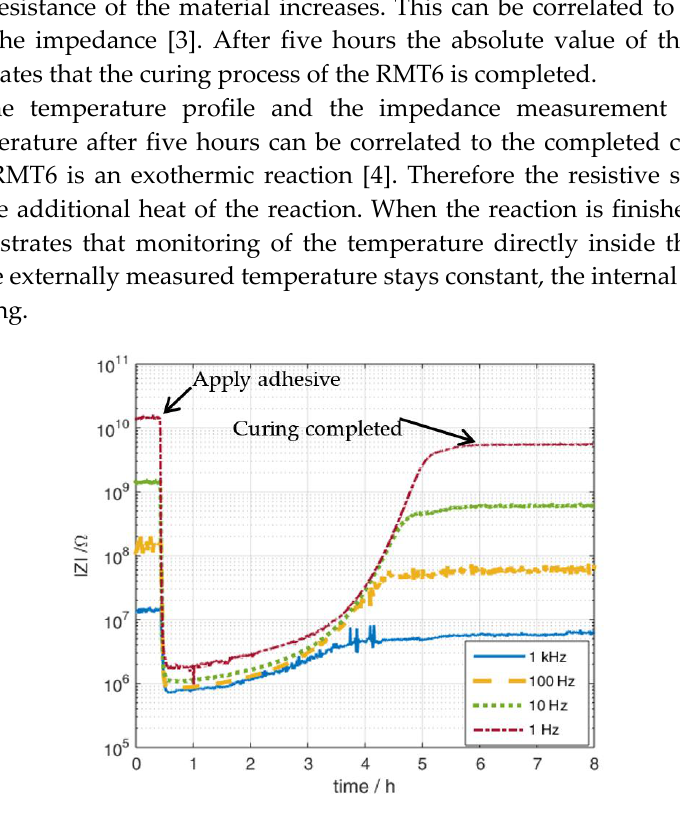
Figure 4. Absolute impedance over time for selected frequencies during curing of RTM6 ( Hexel ) resin. In a first step the RTM6 get less viscous due to the higher temperature (120 °C) which can be seen from the quickly decreasing impedance. Then the curing process starts and the impedance rise. After 5 h curing stops and no changes in the impedance can be